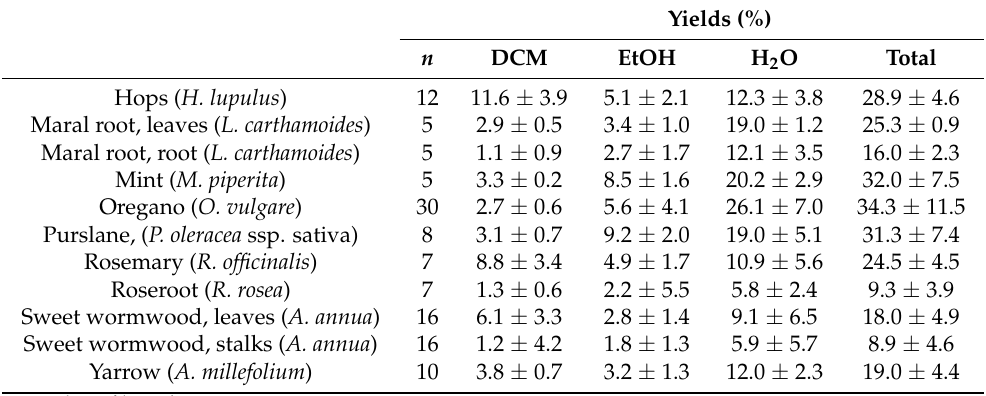
Figure 2. Diagram of sample treatment, sequential extraction, and screening methods for each extract. Table 1. The percentage extraction yields (mean ± SD) on a dry weight basis of nine herb. All extracts were made by ultrasound-assisted extraction (UAE). Extraction was performed in a sequential manner (DCM followed by EtOH and finally by H 2 O).